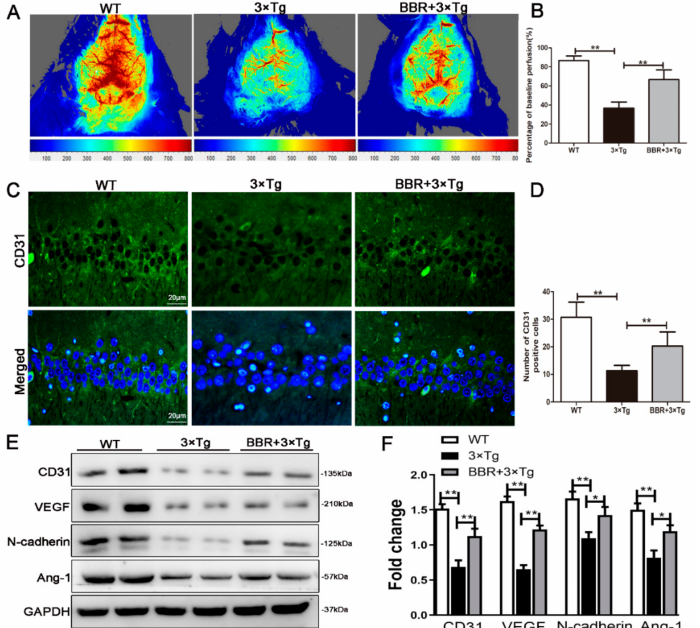
Figure 4. BBR increased the cerebral cortical blood flow perfusion and increased proangiogenic factors in the brains of 3 × Tg AD mice. ( A ) Representative images of cerebral cortical blood flow perfusion in three groups. ( B ) Analysis of the level of cerebral cortical blood flow perfusion in three groups. ( C ) Immunofluorescence of CD31 (green) in the hippocampi of mice from the three groups. Scale bar: 20 µ m. ( D ) Quantification of CD31 immunoreactivity in the hippocampi of mice. ( E ) Western blotting showed protein level of CD31, VEGF, N-Cadherin and Ang-1 in three groups. ( F ) Analysis of protein level of CD31, VEGF, N-Cadherin and Ang-1. WT, wild-type mice; 3 × Tg, 3 × Tg AD mice; BBR + 3 × Tg; 3 × Tg AD mice were given BBR at 100 mg/kg/day. One-way ANOVA and Dunnett’s post-hoc test were used to analyze all the data, which are presented as mean ± SD; n = 12 animals/group. * p < 0.05, ** p <